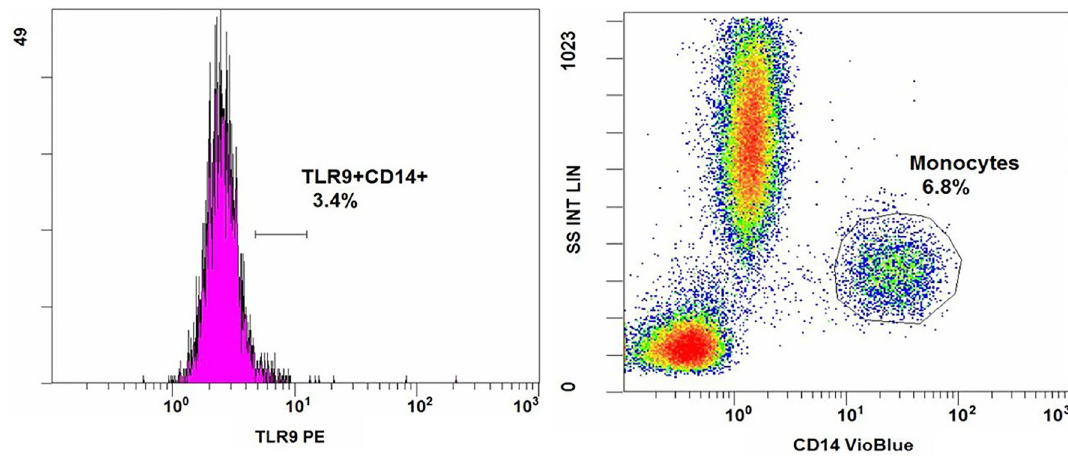
Figure 2. Flow cytometry